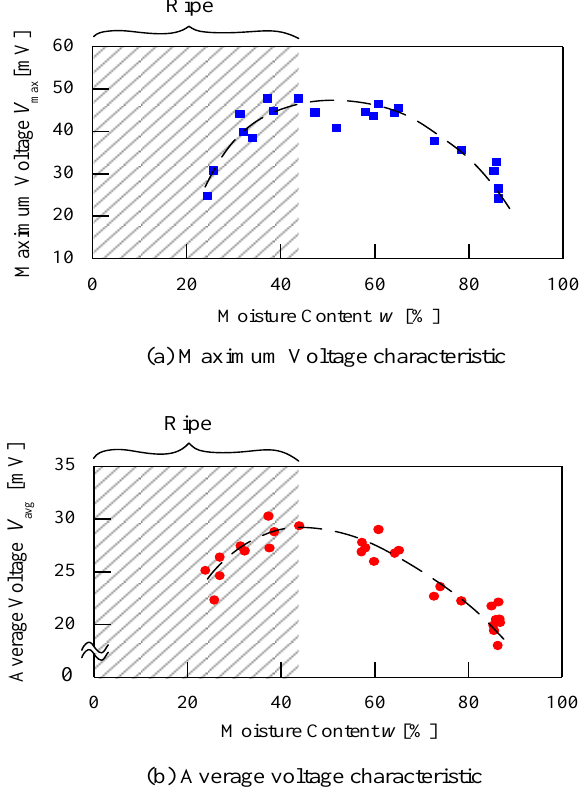
Figure 10. Relationship between moisture content and load resistance voltage. ( a ) Maximum voltage characteristic; ( b ) average voltage characteristic.